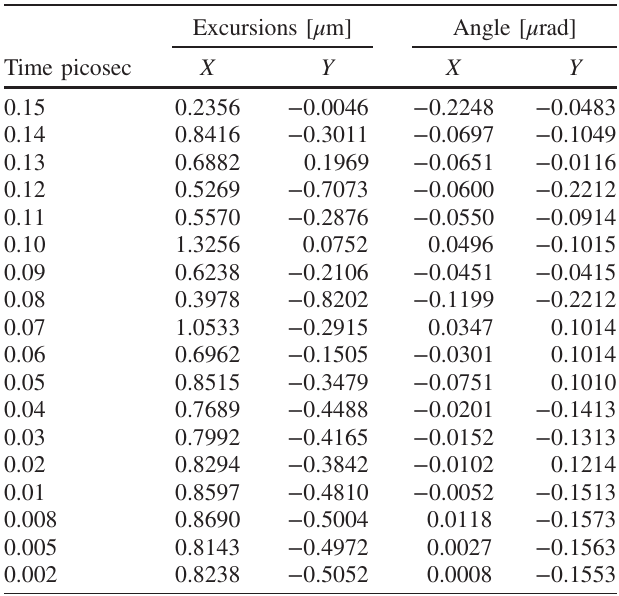
with various time-steps, as shown in Tables I and II and Figs. 2 and 3. We varied the time steps from 0.002 to 0.15 picosec, which is emphasized by vertical colored lines in the graphs, making them into quasilog plots. as a function of time-step used for numerical calculations using Blewett-Chasman fields, for a 120 GeV = c beam entering the snake